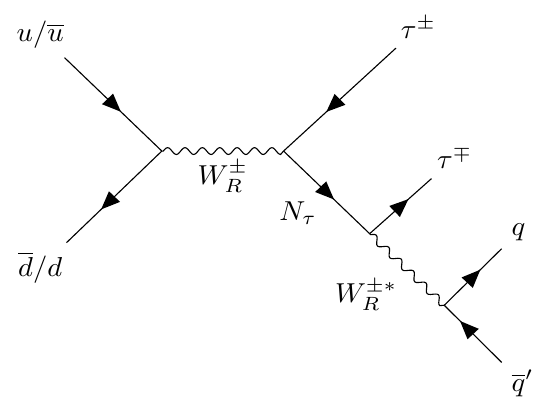
Figure 1 . Leading order Feynman diagram for the production of a right-handed W R that decays to a heavy neutrino N , with a (cid:12)nal state of two (cid:28) leptons and two (cid:28)